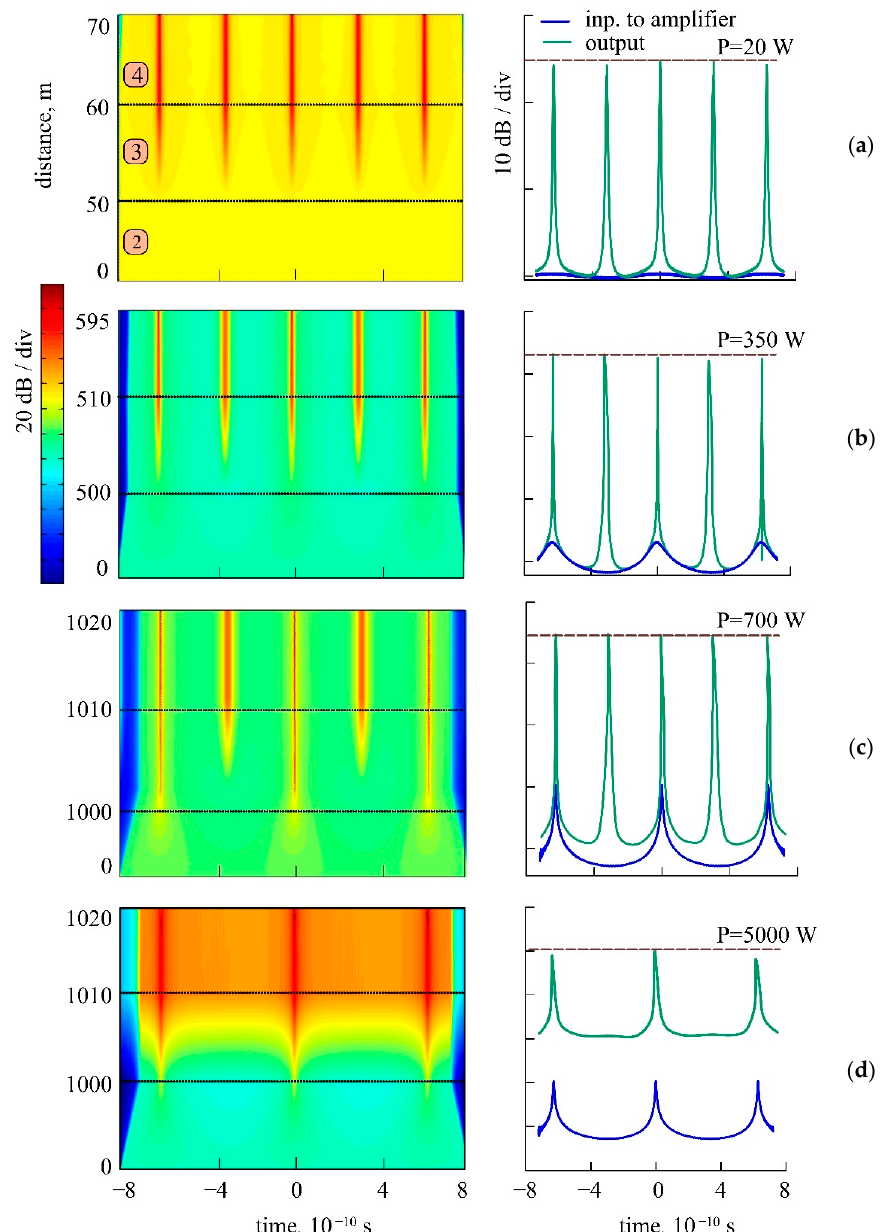
Figure 5. Evolution of time envelope profile in the fiber cascade (2–4) with different passive fiber lengths (cascade 2): 50 ( a ), 500 ( b ), 1000 m ( c ), and ( d ) and amplifier length of 10 m. (Right) Time profiles of pulse trains in semi-logarithmic scale at the amplifier input (blue curves) and output (green curves). Gain bandwidth is ∆ ω l = 10 12 s − 1 ( a – c ) and ∆ ω l = 4 × 10 13 s − 1 ( d ) at g ∼ 0.3 m − 1